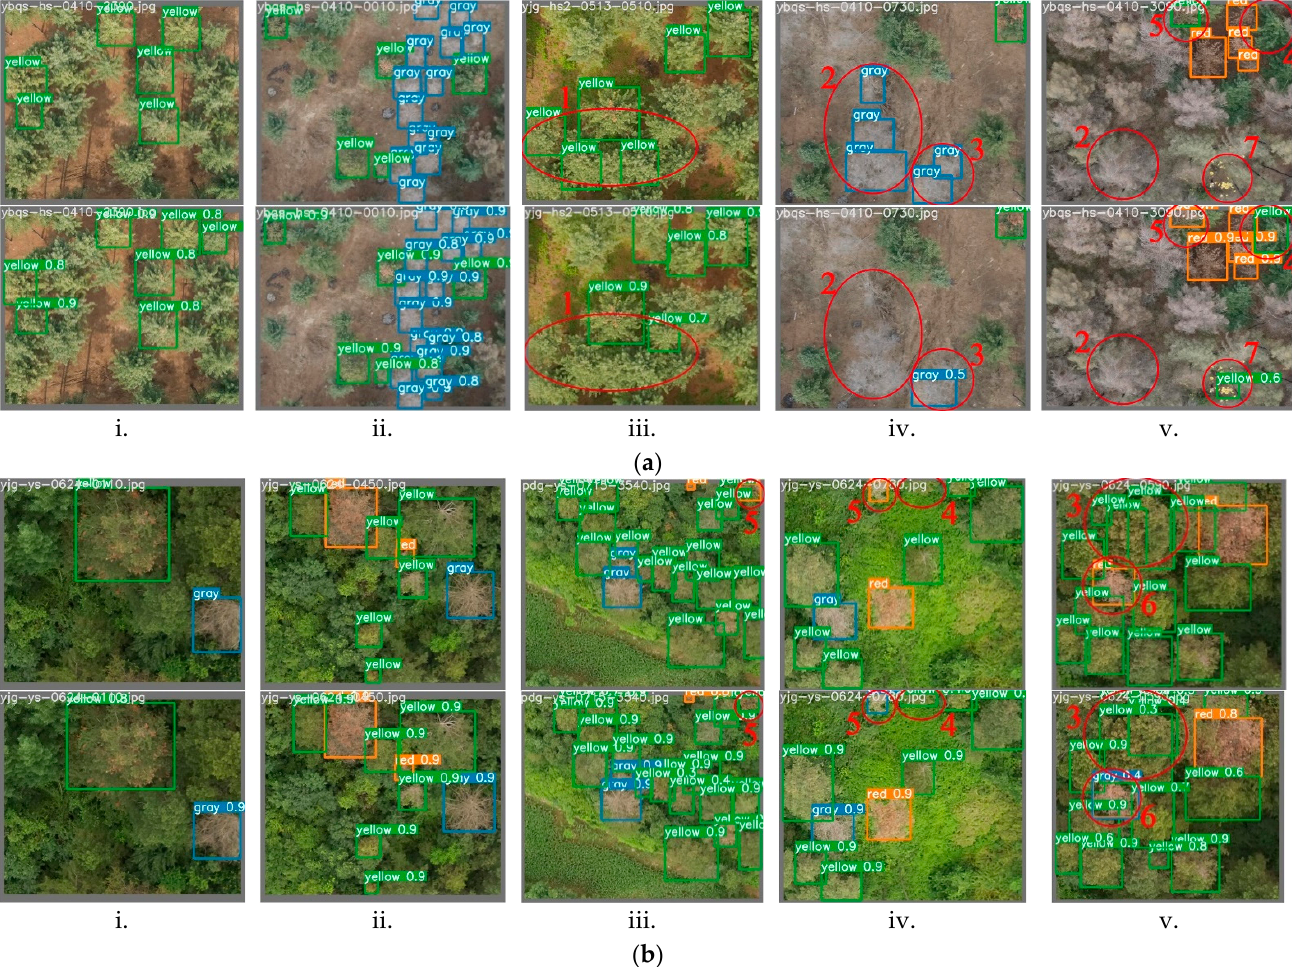
Figure 12. Detection Results of Infected pine trees with PWD, where the 1–7 represent the numbers of the error areas and i.–v. are the numbers of the result images: ( a ) Detection results on KP dataset, ( b ) detection results on CP dataset.